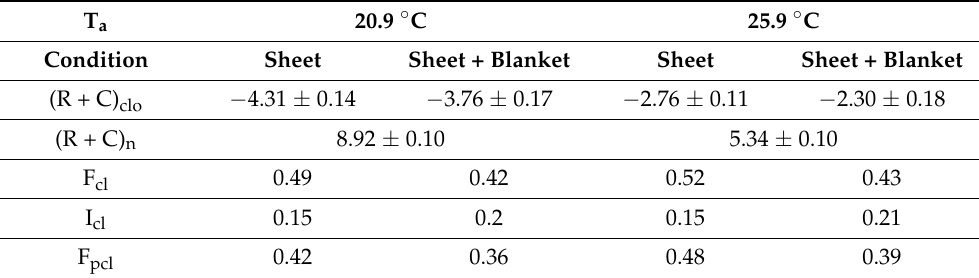
Table 1. Variables characterizing the total thermal insulation provided by the covering (sheet or sheet + blanket) and clothing (cap and diaper) during simulated SSC. R and C are, respectively, the radiative and convective heat losses (in W/kg) for the clothed (clo) or nude (n) mannequin. F cl , I cl, and F pcl are, respectively, the reduction coefficients of dry and the insulation provided by the covering and clothing (m 2 ◦ C/W). F pcl is the reduction in latent heat exchange. T a 20.9 ◦ C 25.9 ◦ C Condition Sheet Sheet + Blanket Sheet Sheet + Blanket (R + C) clo − 4.31 ± 0.14 − 3.76 ± 0.17 − 2.76 ± 0.11 − 2.30 ± 0.18 (R + C) n 8.92 ± 0.10 5.34 ±